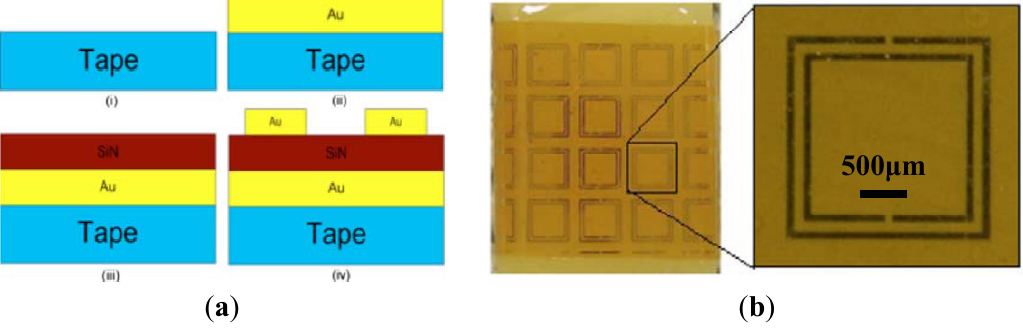
Figure 12. ( a ) Fabrication procedure of the tape-based flexible sensor and ( b ) The final fabricated structure of the tape-based flexible sensor